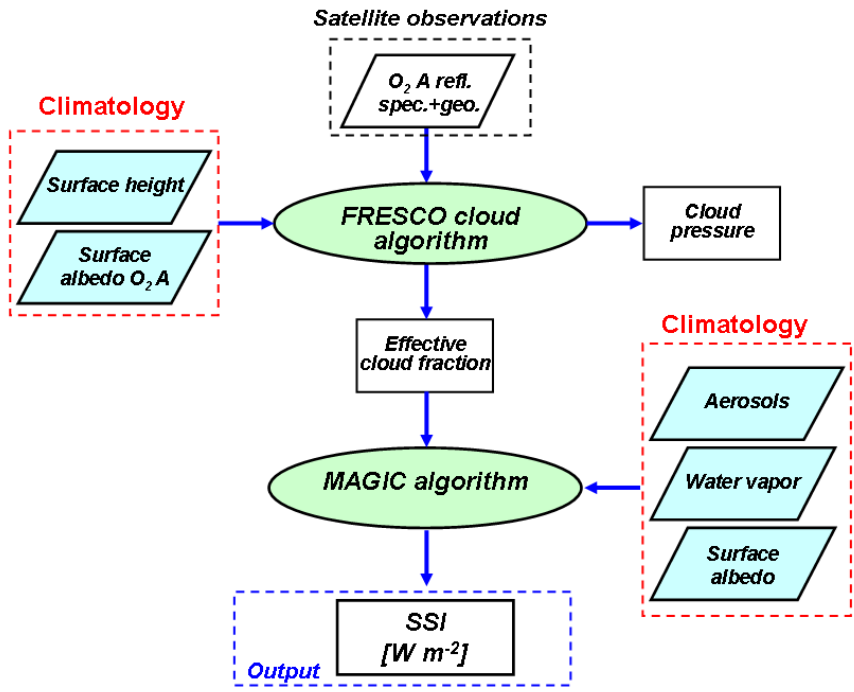
Fig. 1. Flowchart of the FRESCO surface solar irradiance (SSI) algorithm. Figure 1. Flowchart of the FRESCO surface solar irradiance (SSI) algorithm. 2 2 FRESCO SSI